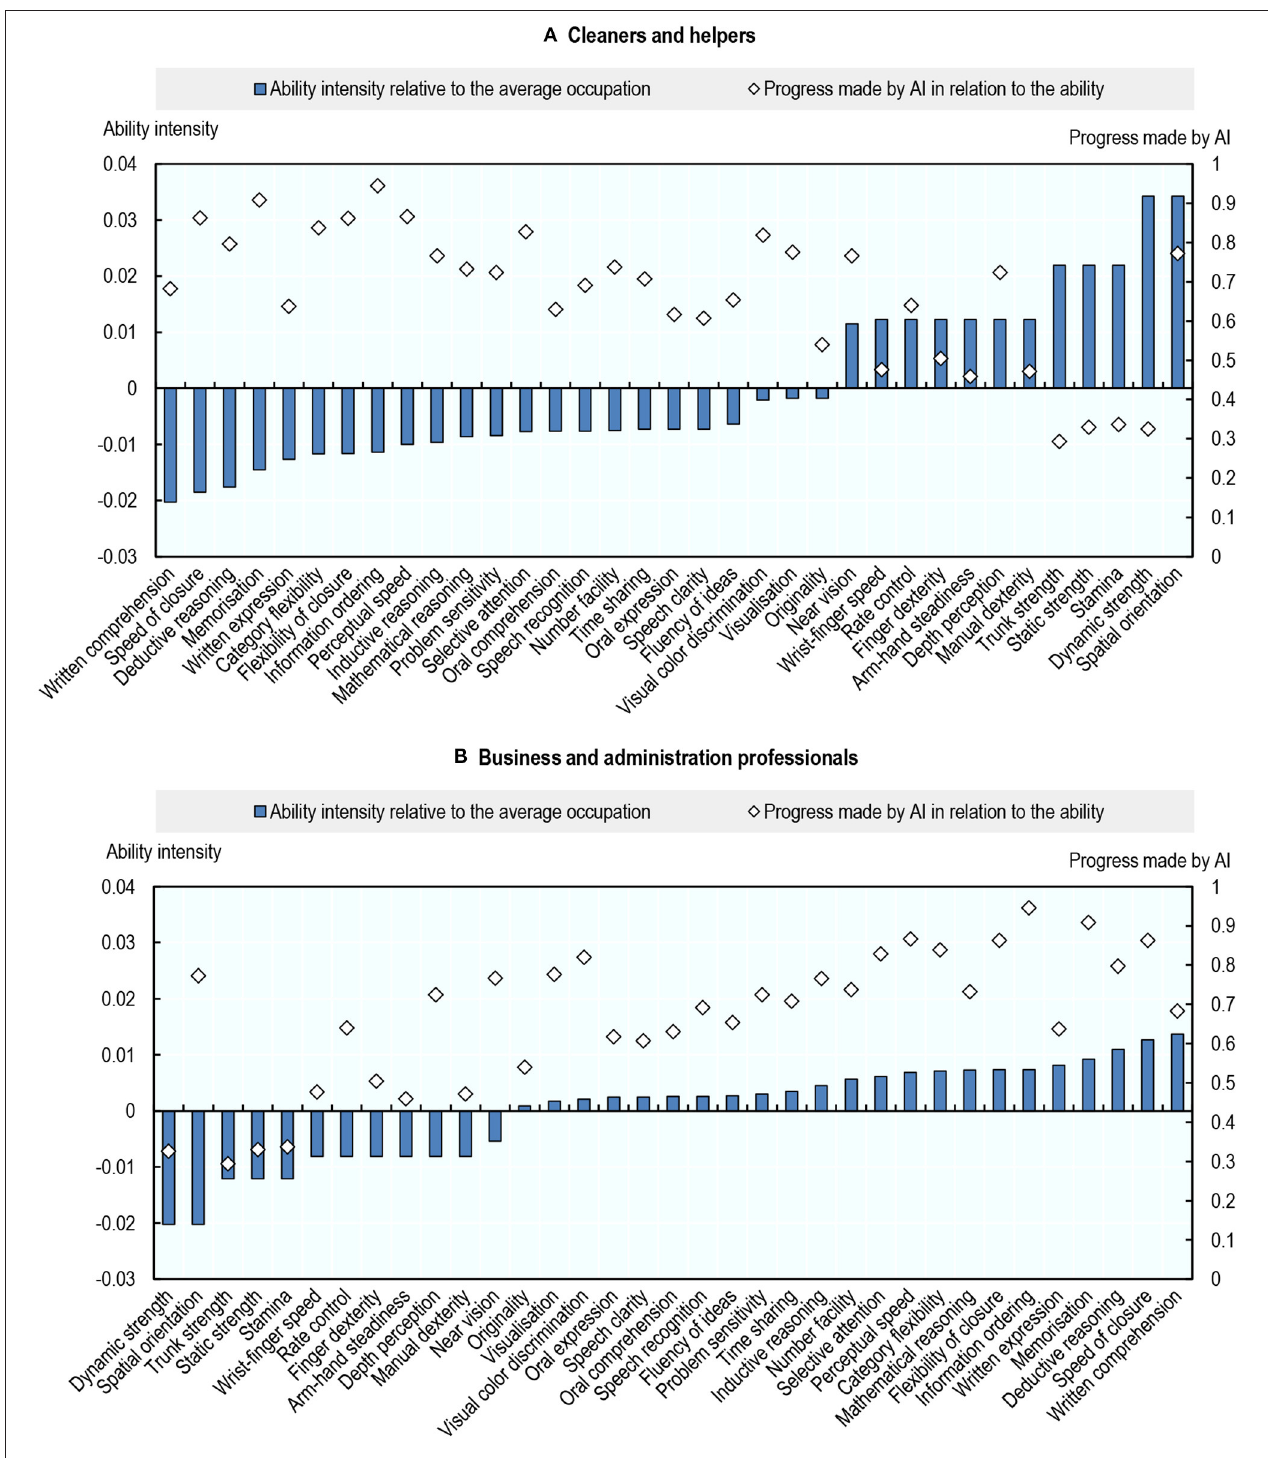
FIGURE 5 | Cross-occupation differences in AI exposure are caused by differences in the intensity of use of abilities. Intensity of use of an ability relative to the average across occupations, and progress made by AI in relation to that ability, 2012. Ability intensity represents the cross-country average frequency of the use of an ability among Cleaner and helpers (top) or Business professionals (bottom) minus the cross-country average frequency of the use of that ability, averaged across the 36 occupations in the sample. Authors’ calculations using data from the Programme for the International Assessment of Adult Competencies (PIAAC) and Felten et al. (2019). (A) Cleaners and helpers and (B) Business and administration